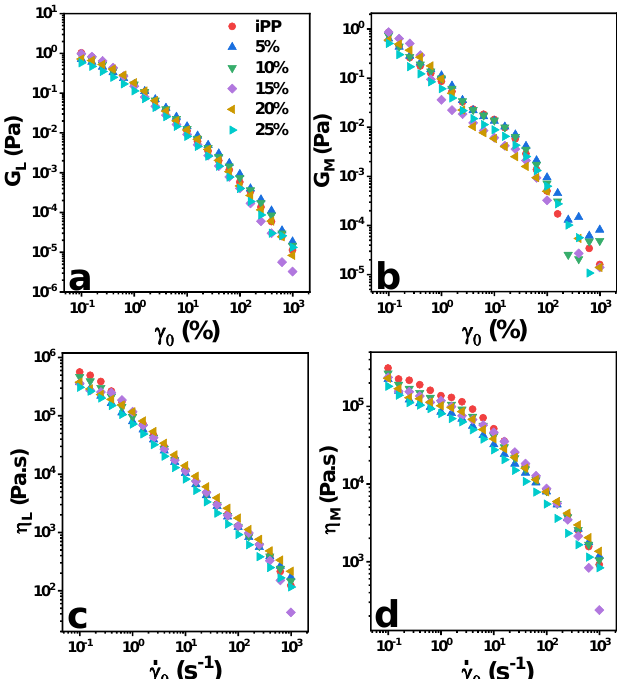
Figure 7. Large-strain elastic modulus ( G L ; a ), minimum-strain elastic modulus ( G M ; b ), large strain-rate dynamic viscosity ( η L ; c ) and minimum strain-rate dynamic viscosity ( η M ; d ) as a func- tion of strain-rate amplitude 𝛾̇ 0 and strain amplitude γ 0 under LAOS stress for pure iPP, LMPP and blends at 1.0 rad s −1